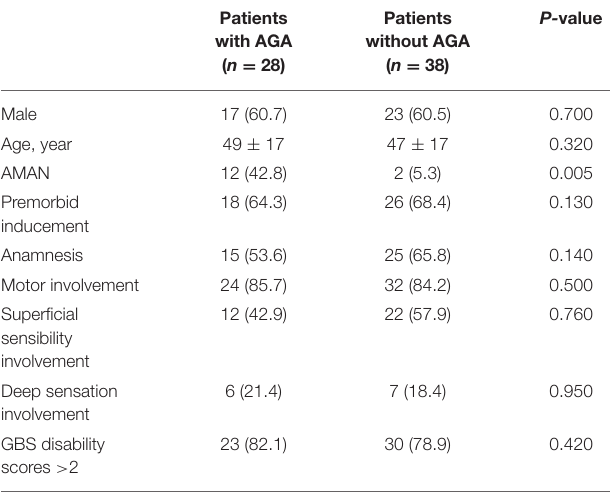
TABLE 2 | Characteristics comparison between patients with AGAs or